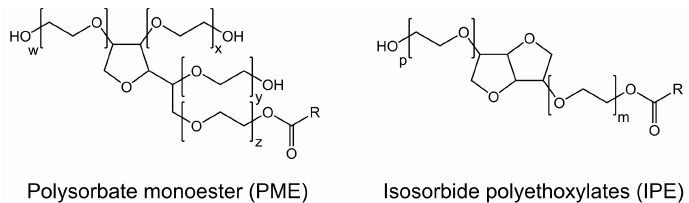
Figure A2. Molecular structures of the two major components found in commercially available Tween20: polysorbate monoester (PME) and isosorbide polyethoxylate (IPE). –R denotes the alkyl chain, –C 11 H 23 .